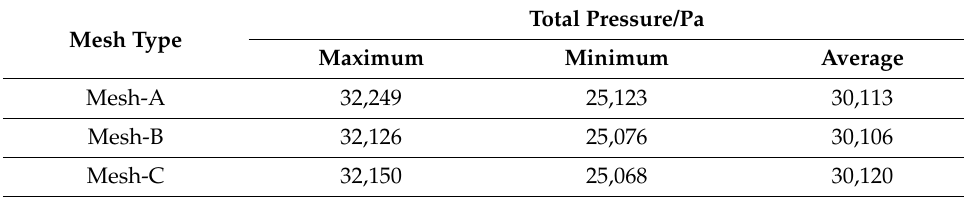
Table 5. Total pressure statistics at outlet.